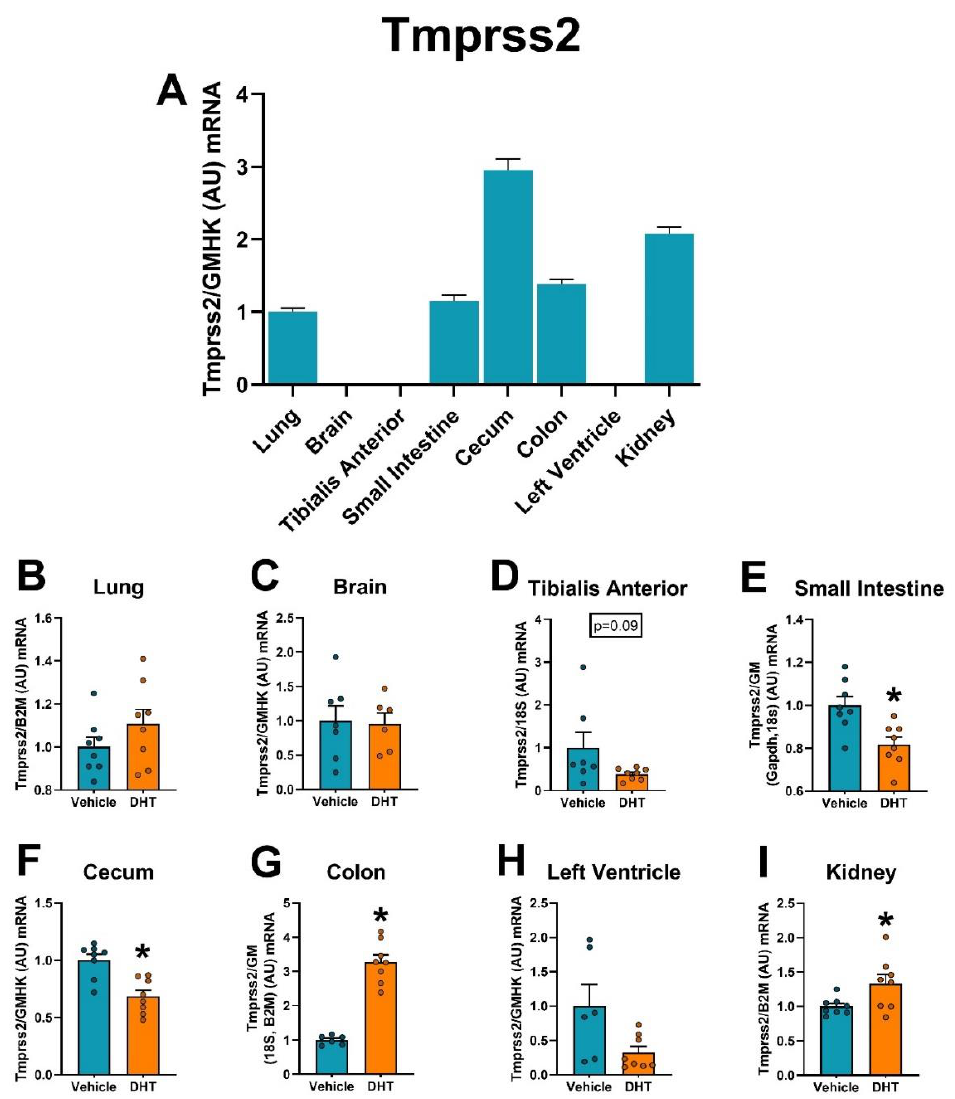
Figure 6. Tmprss2 mRNA expression regulation by DHT in different tissues. Tmprss2 mRNA expression was quantified by RT-qPCR. ( A ) Tmprss2 mRNA expression in control mice normalized to the geometric mean of all reference genes and expressed relative to lung tissue. ( B – I ) Tmprss2 mRNA expression in the lung ( B ), brain ( C ), tibialis anterior ( D ), small intestine ( E ), cecum ( F ), colon ( G ), left ventricle ( H ), and kidney ( I ) of control and DHT-treated mice normalized to the least variable reference gene or set of them and expressed relative to control mice. Data analyzed by t -test. n = 7–8/group. *: p < 0.05.